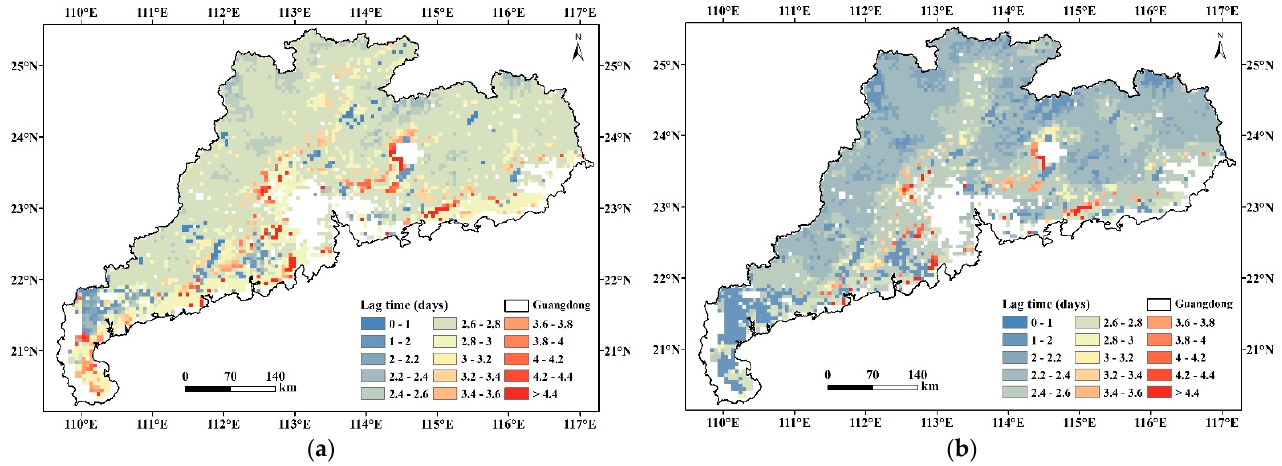
Figure 11. The spatial distribution of lag time of the peak ( a ) and valley ( b ) between CRDI and VSWC. The gradual change of color indicates the change of lag time.